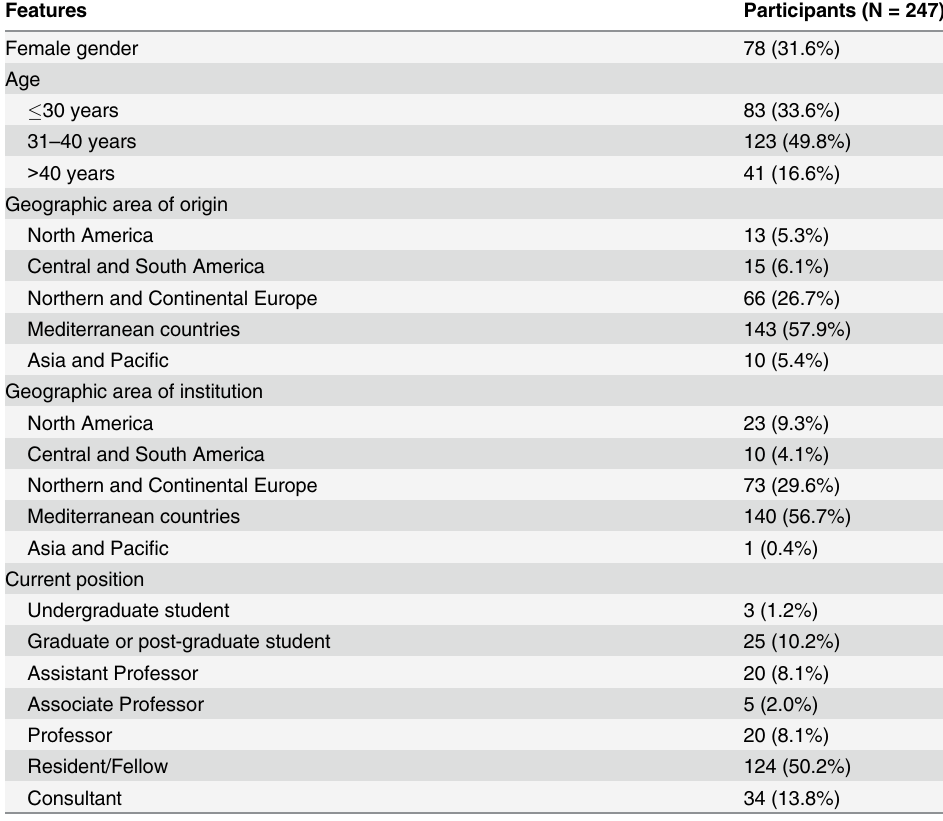
Table 1. Characteristics of participants to the